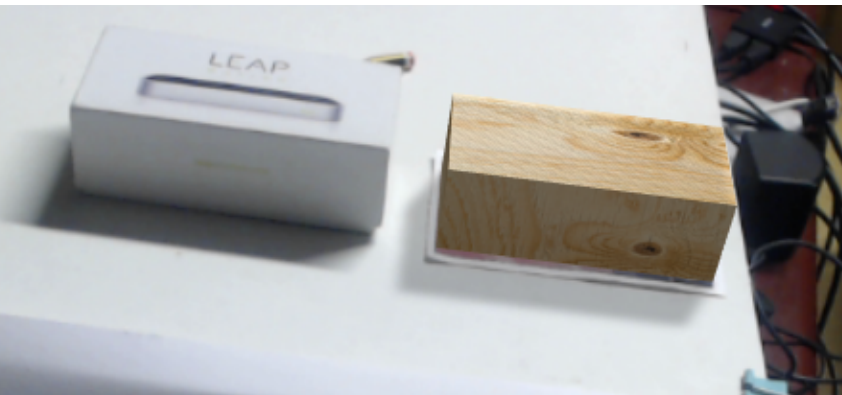
Figure 28. Example of planar shadow